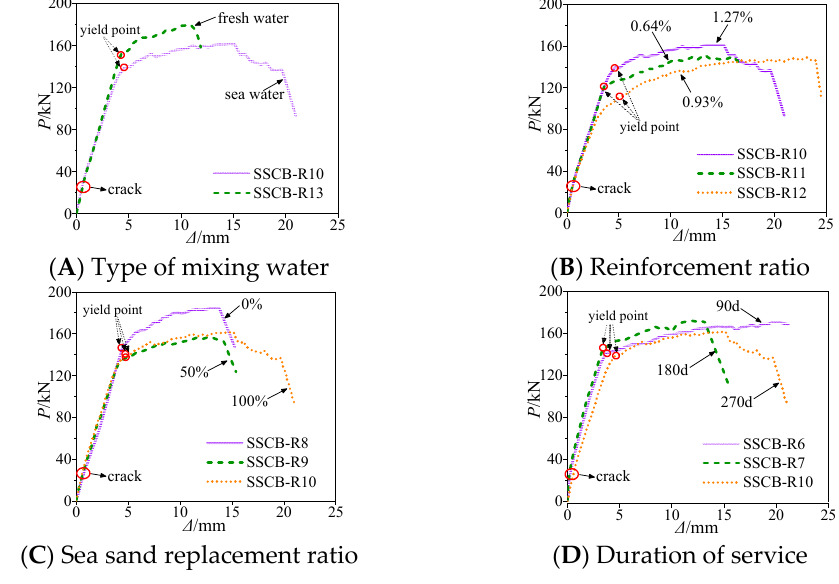
Figure 6. Load–deflection curve.